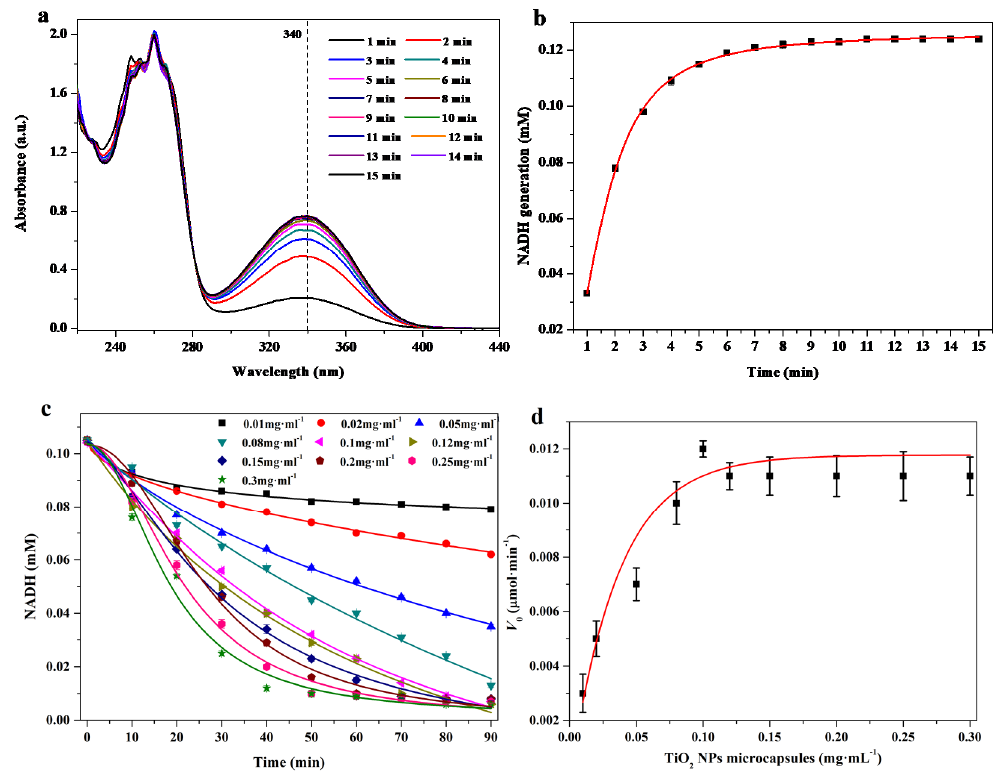
Figure 3. UV ‐ Vis spectra showing that the increase in absorption intensity at 340 nm is consistent with the reduction of NAD + to NADH in a reaction mixture containing NAD + (1 mM, 300 μ L), ethanol (50%, 100 μ L), and ADH (10 μ g ∙ mL − 1 , 100 μ L) at 37 °C and pH 7.5. ( a ) Corresponding plots of intensity at 340 nm vs. time; ( b ) Plots of NADH concentration vs. time. UV ‐ Vis absorption intensity at 340 nm was consistent with the oxidation of NADH to NAD + under visible light irradiation in a reaction mixture containing NADH (1 mM, 200 μ L), TiO 2 NP microcapsules without ADH and with varying TiO 2 NP microcapsules concentrations from 0.01 to 0.3 mg ꞏ mL − 1 at 37 °C and pH 7.5; ( c ) Corresponding plots of NADH concentration decreasing vs. time; ( d ) Initial velocity ( V 0 ) vs. concentration of the microcapsules.